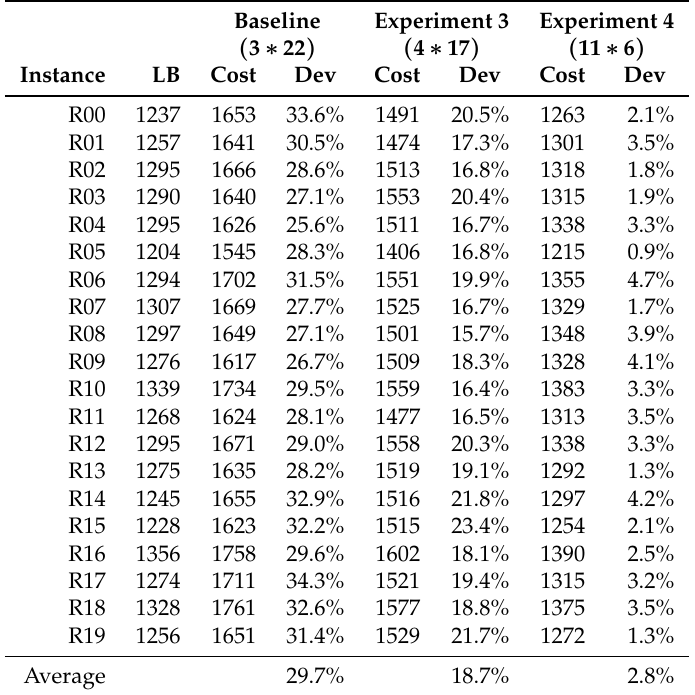
Table 3. Results for instances with 66 customers and three different container configurations, given as ( R ∗ L )